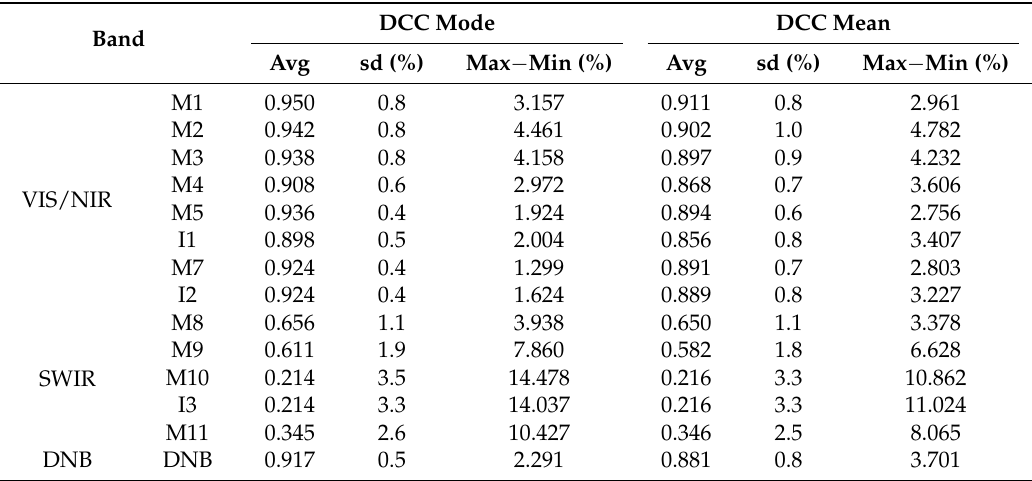
Table 3. Statistics of monthly DCC reflectance (after the ADM adjustment) mean and mode time